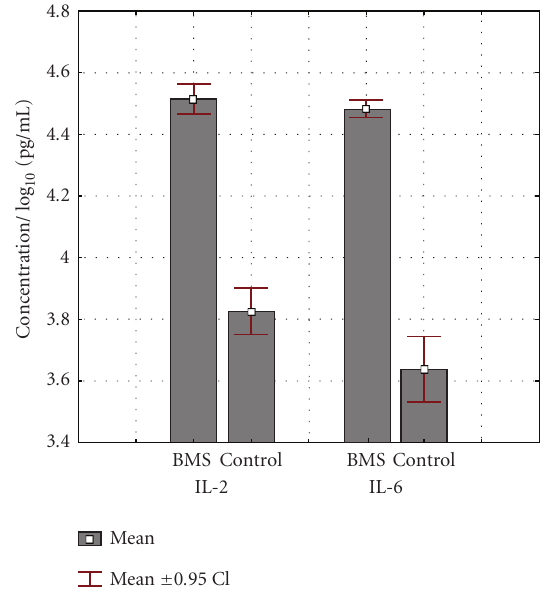
Figure 1: Comparison of IL-2 and IL-6 levels in the patients with BMS and healthy individuals (controls). Data represent the mean log cytokine content (IQR) in pg per milliliter of saliva derived from 30